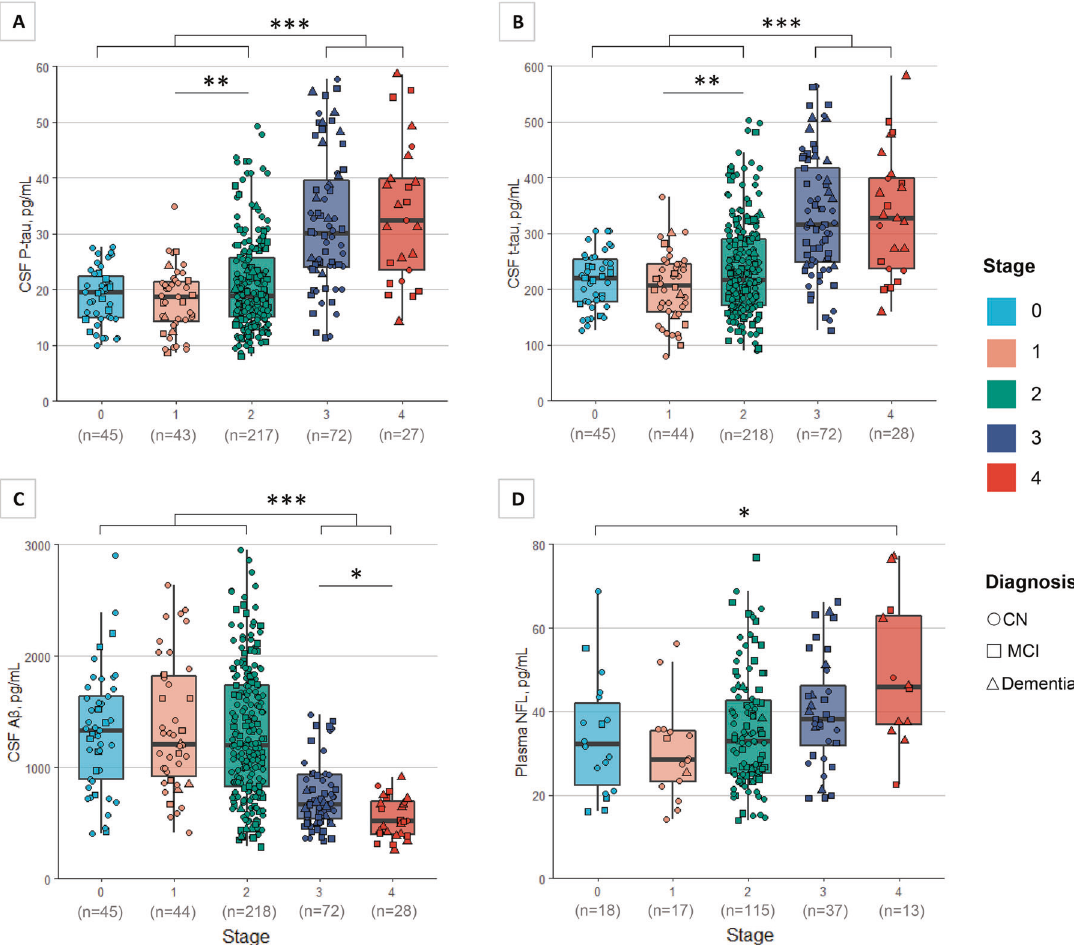
Fig. 3 Baseline CSF biomarkers and plasma NFL pro fi les across tau stages. A CSF p-tau across stages. B CSF t-tau across stages: CSF p-tau/t- tau levels were signi fi cantly higher for stage 3 and stage 4 respectively compared with stages 0, 1, or 2. Stage 2 signi fi cantly differed from stage 1. C CSFA β levels across stages: CSFA β levels were signi fi cantly lower for stage 3 and stage 4 respectively compared with stage 0, 1, or 2. Stage 4 marginally differed from stage 3 ( P = 0.057). D Plasma NFL levels across stages: No signi fi cant difference was detected among stages for plasma NFL( P = 0.095). Under the horizontal axes are numbers of included participants in comparison. CN cognitively normal, MCI mild cognitive impairment, NFL neuro fi lament light chain, p-tau phosphorylated tau, t-tau total tau. * P < 0.1; ** P < 0.05; *** P <